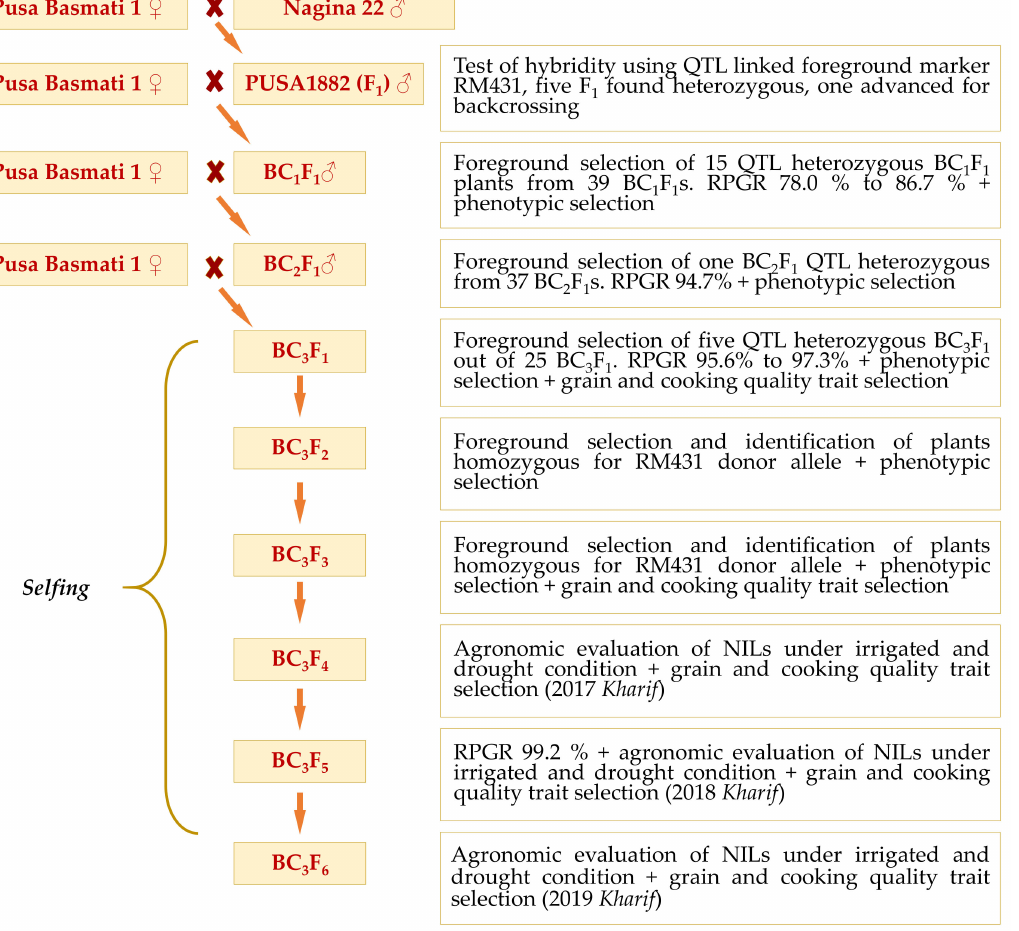
Figure 1. Breeding scheme used in the marker-assisted backcross program for the transfer of qDTY1.1 quantitative trait locus (QTL) in the background of the elite rice variety, Pusa Basmati 1. Recurrent parent genome recovery (RPGR) denotes recurrent parent genome